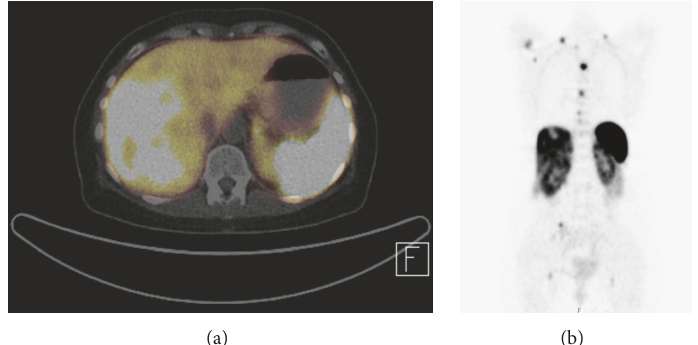
Figure 3: Somatostatin receptor imaging with CT-scan (PET-CT) (a) showing extensive liver metastasis in the right liver lobe in 12/2011 and (b) additionally showing